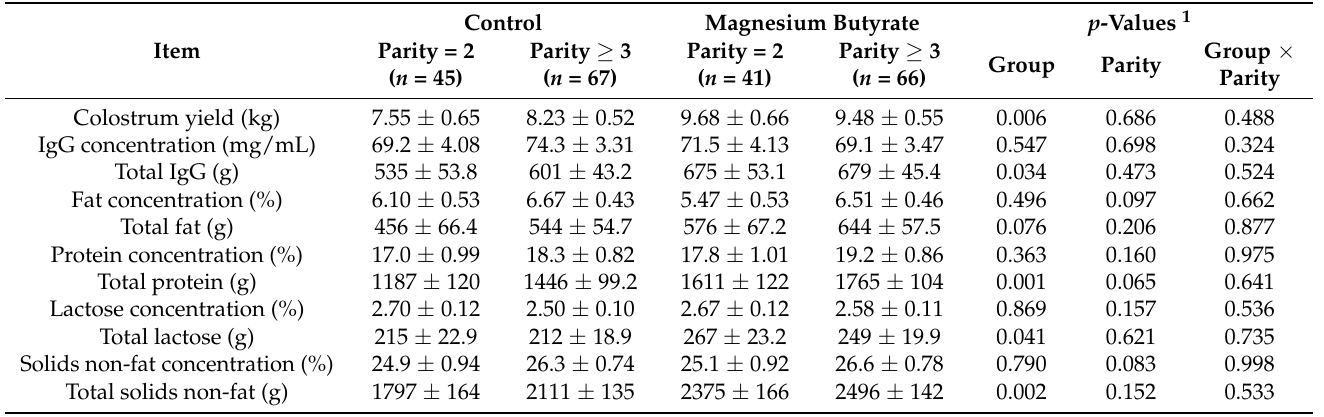
Table 2. Colostrum yield and chemical analysis variables (least squares means and standard error) of Control ( n = 112) and Magnesium butyrate ( n = 107) cows.